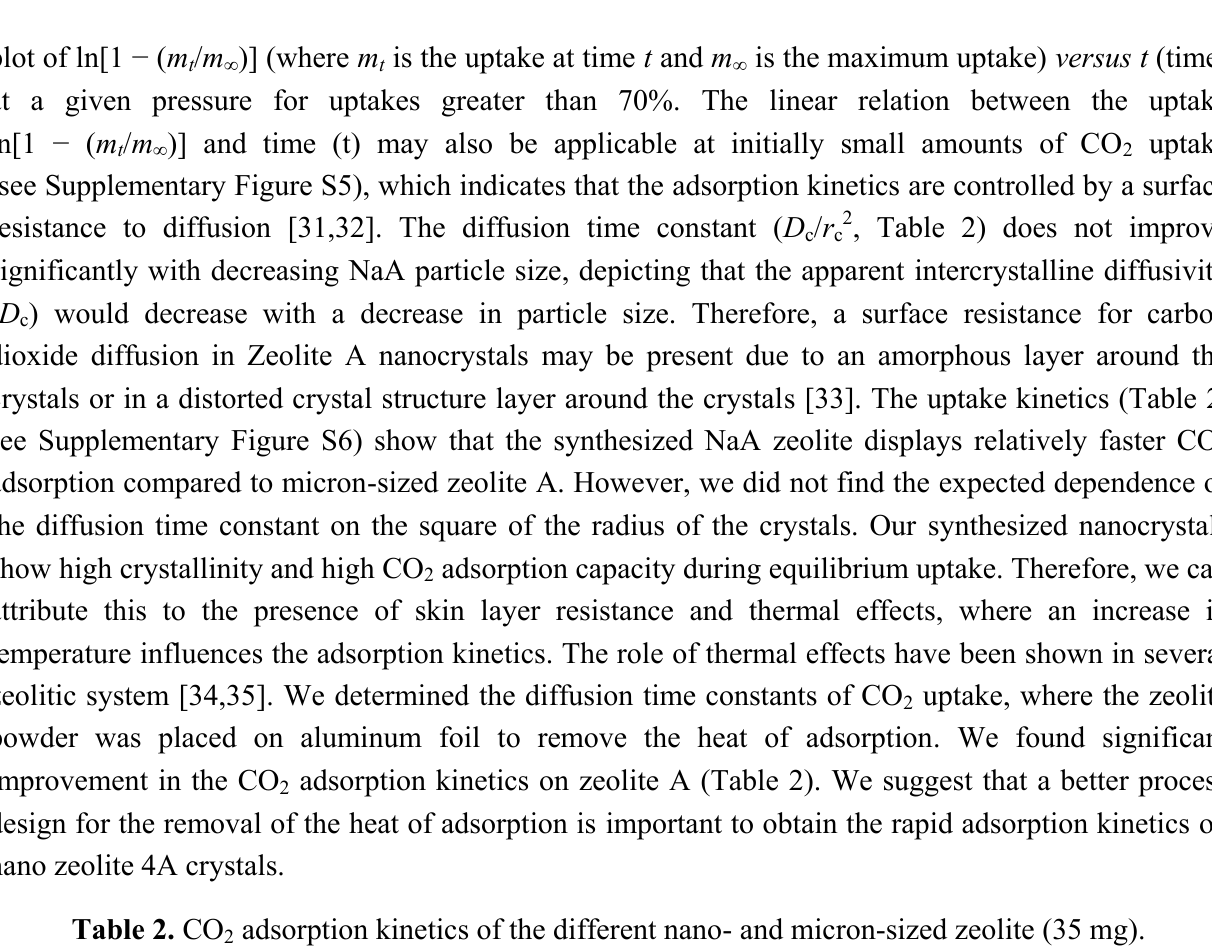
Table 2. CO adsorption kinetics of the different nano- and micron-sized zeolite (35 mg). 2 Zeolite Zeolite A Z0 NZ010 NZ020 NZ040 Diffusion